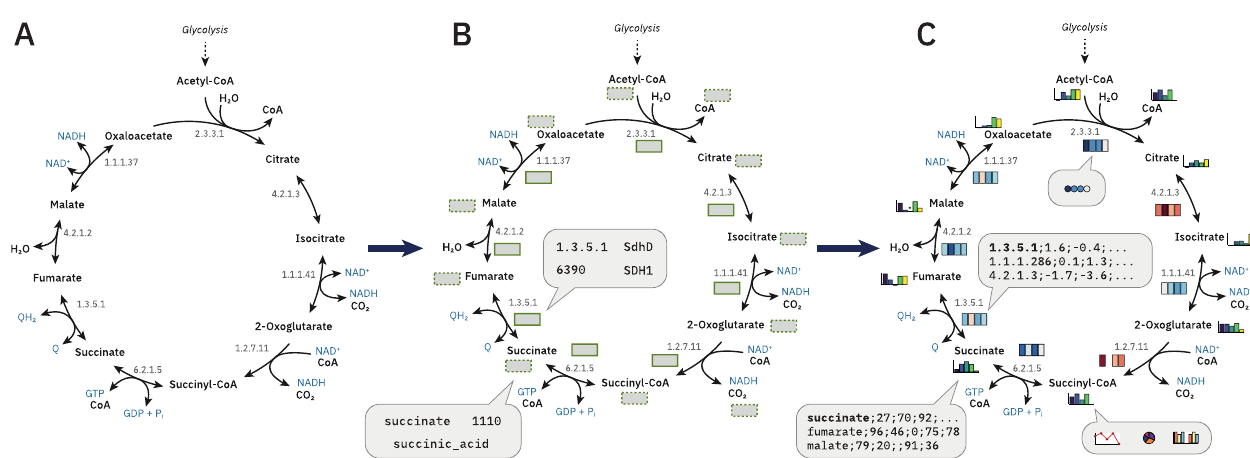
Figure 1. The process of data visualization on MetaboMAPS. ( A ) Upload the metabolic pathway in SVG format. Alternatively, you can use an existing pathway. ( B ) Draw plot boxes for metabolite (dashed border) and reaction (solid border) associated data. Assign identifiers to each plot box (e.g. EC numbers, locus tags, GI, metabolite synonyms, database IDs). ( C ) Load your own data set (as CSV file) and visualize reaction and metabolite dependent data